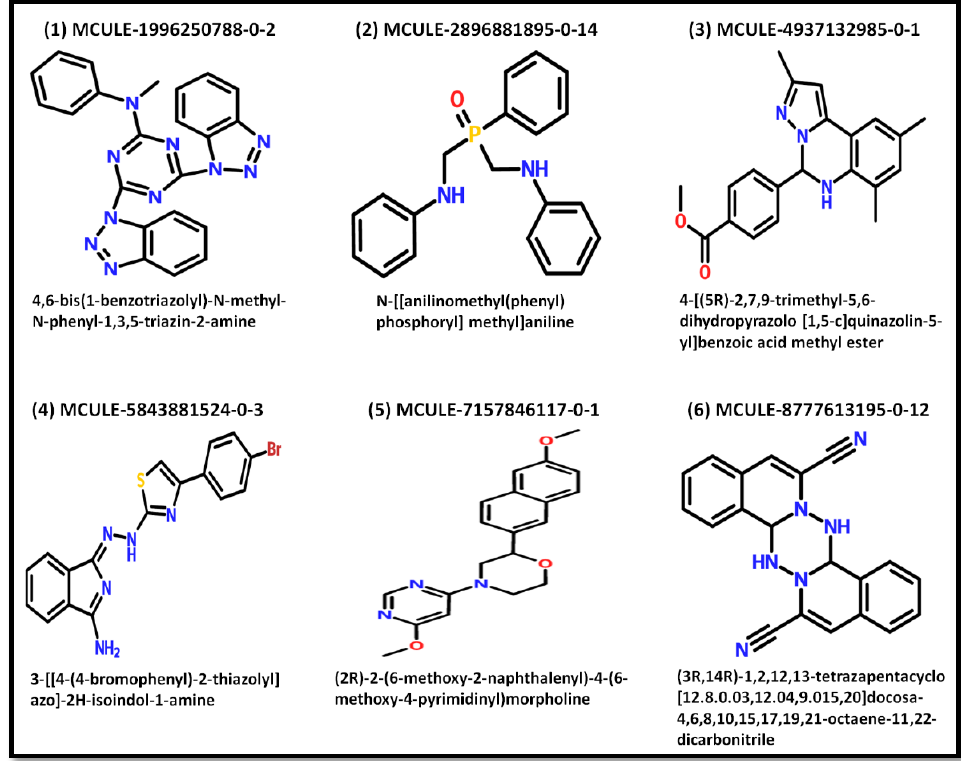
Figure 1. The 2D structures and chemical names of the shortlisted ligands obtained after virtual screening. Table 1. List of top 100 ligands identified by screening MCULE’s purchasable library using Auto- Dock Vina.